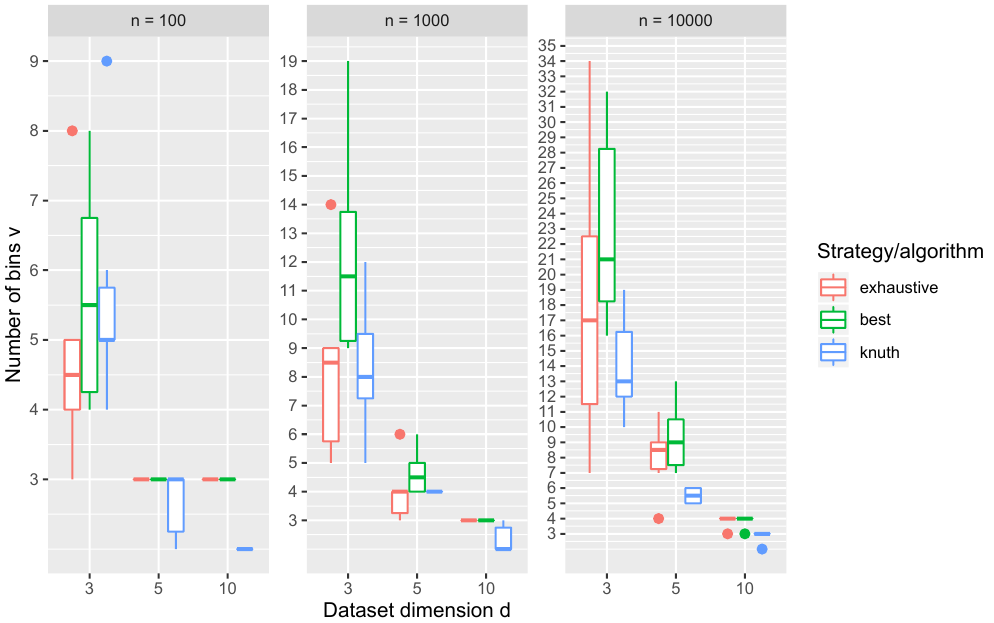
Figure 14. Optimal number of bins v selected with the different strategies and Knuth rule on the artificial datasets from Section